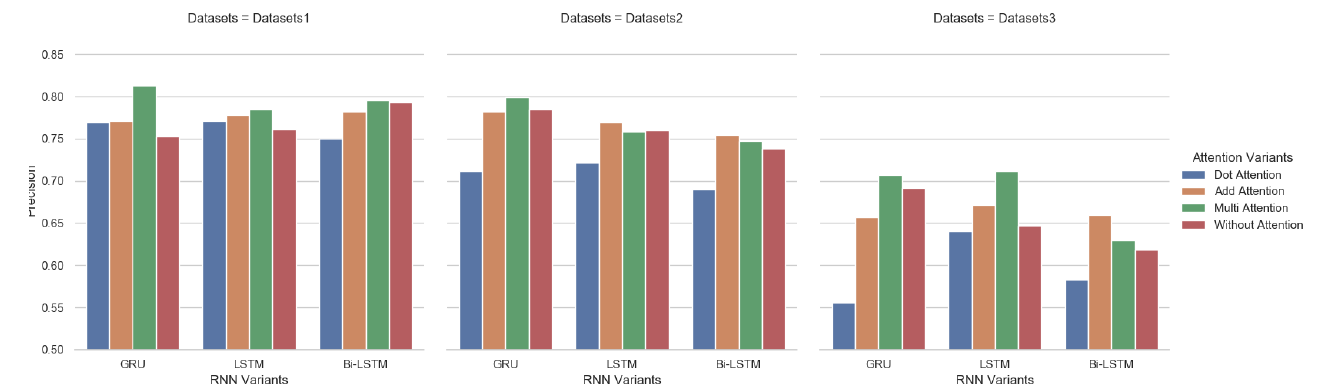
Figure 7. Result comparison with different RNNs units and attention scores. The figure describes the influence of different attention mechanisms and RNN models in Hi-STEM on the results under different data